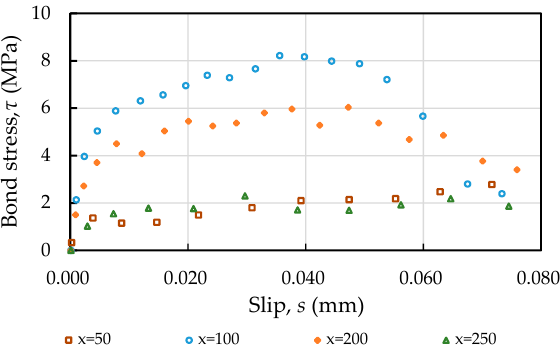
Figure 13. Bond stress vs. slip relationship along embedded length with the same slip value: ( a ) C20, ( b ) C40, and ( c ) C60. Figure 12. Bond stress–slip relationship curve at different positions of the specimen (taking concrete C20 as an example).